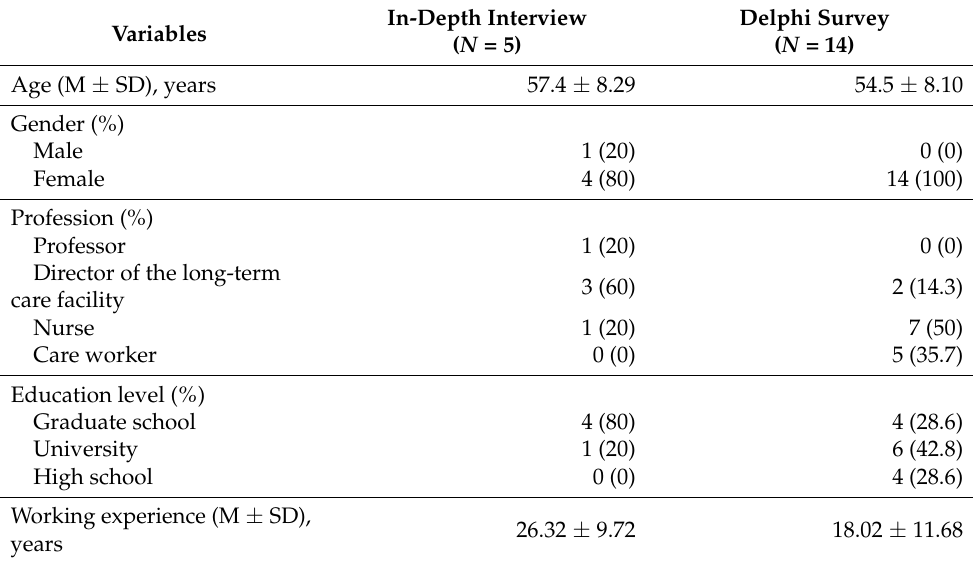
Table 1. General characteristics of participants of the in-depth interviews and the Delphi survey.